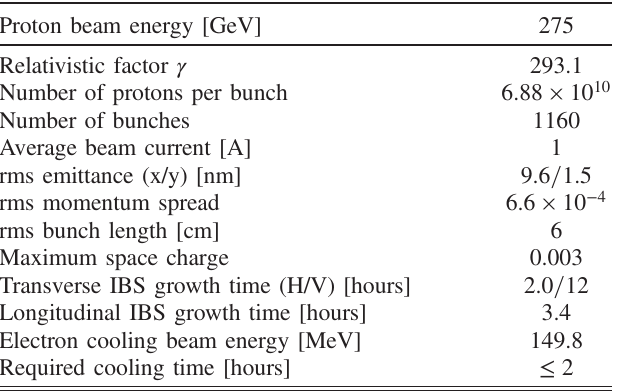
TABLE I. Proton beam parameters for cooling.